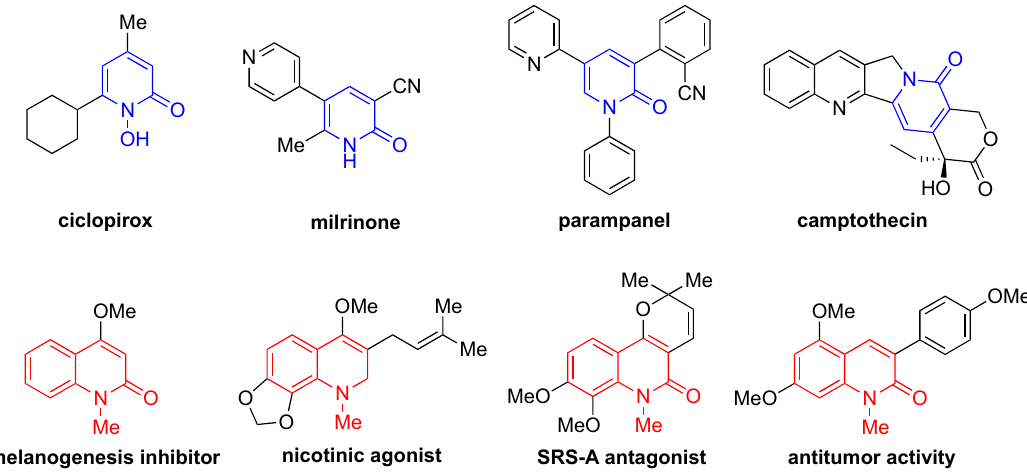
Figure 1. Biological activities of pyridones and quinolones.